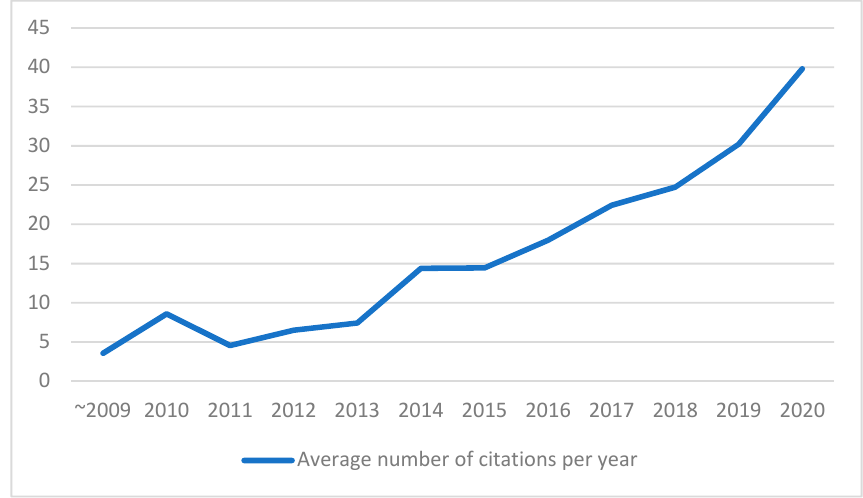
Figure 7. Average number of citations per year.